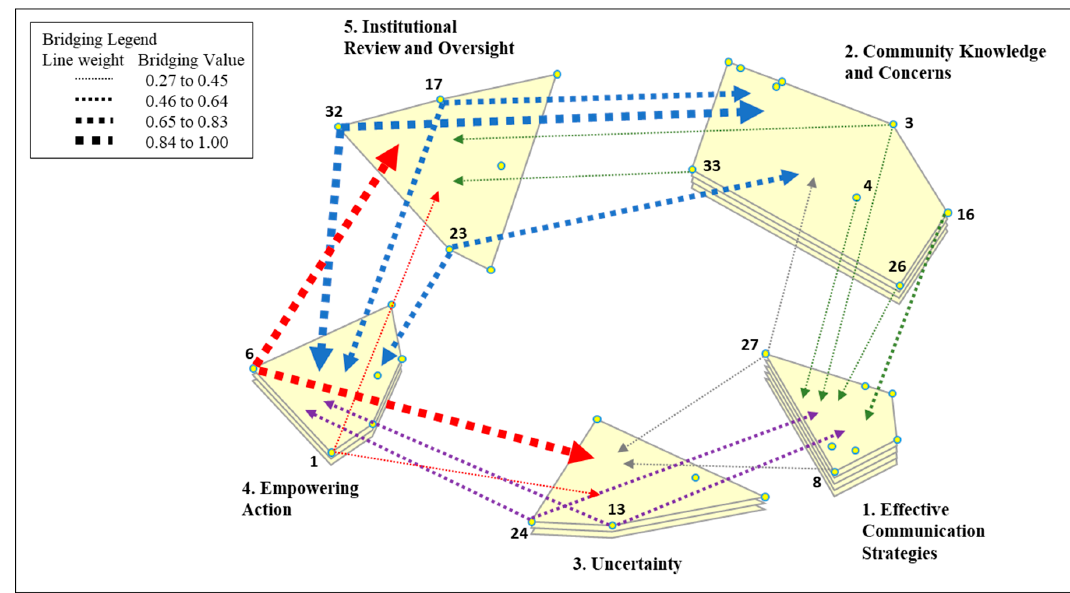
Figure 2. Cluster Rating Map with Highly Bridged Statements. Arrows come from statements with bridging values above the cluster mean and point towards the cluster that they were frequently sorted with. The weight of the arrow indicates the bridging value, with heavier lines indicating a statement that was more frequently sorted with other clusters, i.e., spanned to other areas of the map because participants conceptualized them as interrelated with other themes.